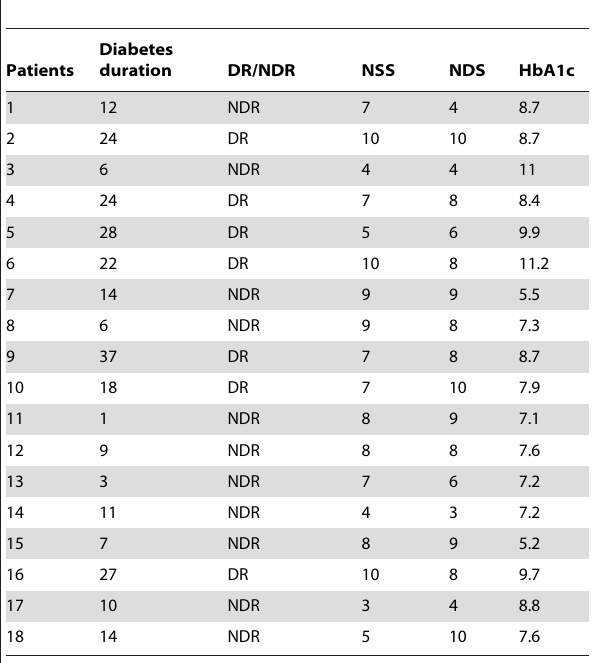
Table 2. Clinical data of individual patients in diabetes group (data presented as mean 6